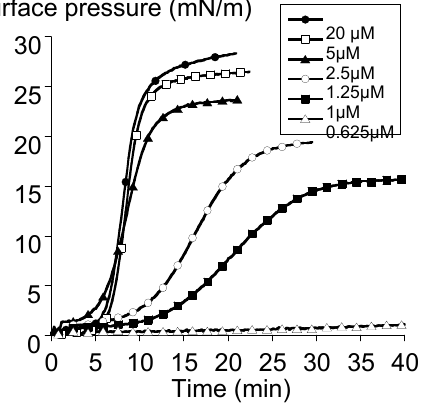
Figure 3. Surface activity of the bolaamphiphile 3 . Kinetics of bolaform adsorption at the air-water interface. Time zero corresponds to the injection of the bolaform into the subphase.